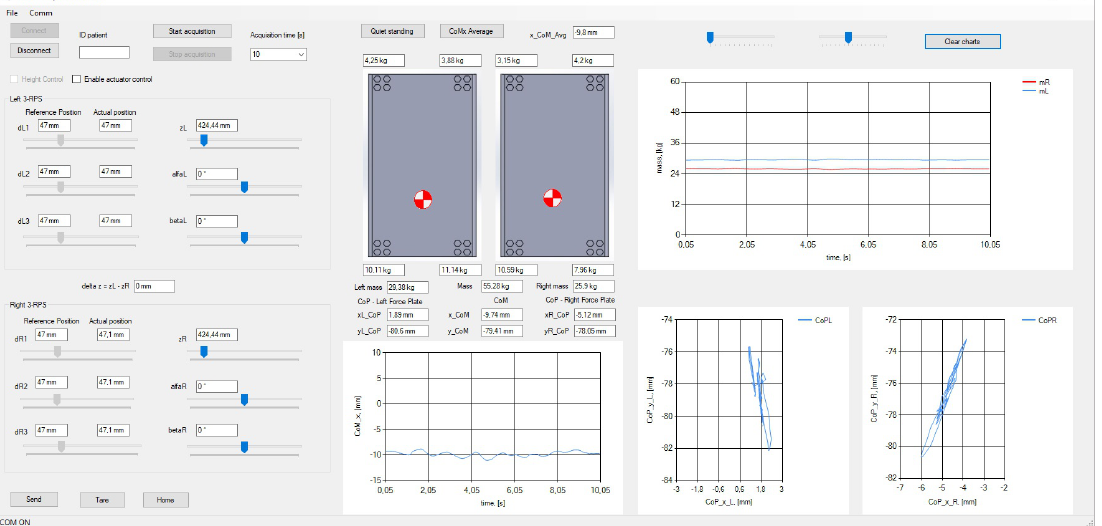
Figure 17. PC application for control and data